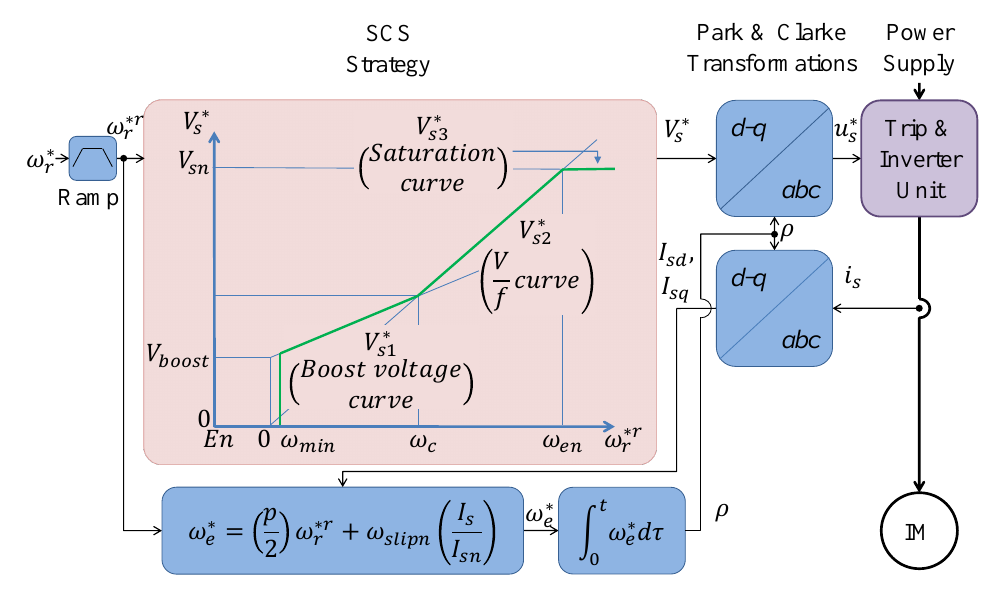
Figure 1. Standard SCS block diagram for IM